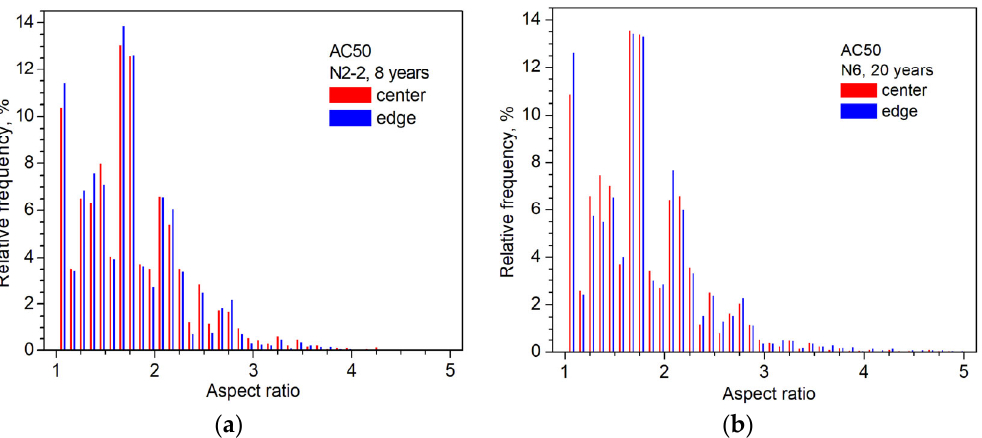
Figure 5. Histograms of grain aspect ratio distribution for the centers and edges of cross-sections of outer wires from the AC50 cables after ( a ) 8 years of service (N2-2) and ( b ) 20 years of service (N6). For better visualization, the histograms for sample edges are shifted along the abscissa axes in ( a , b ).